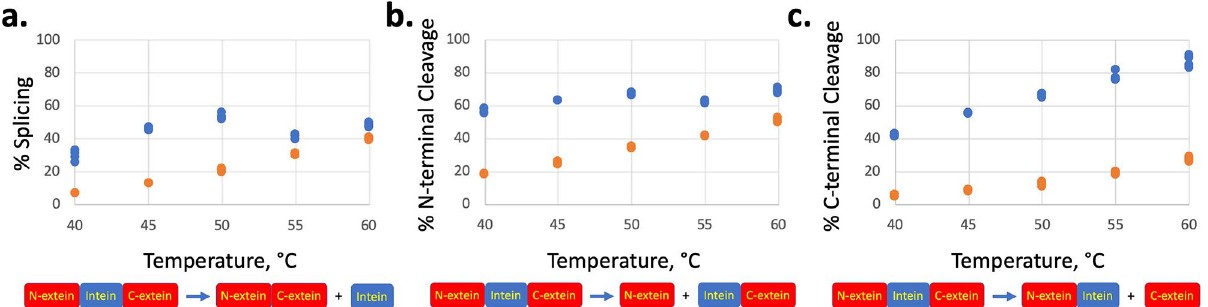
Figure 2. Protein splicing and splicing side reactions of the P. abyssi and P. horikoshii PolII inteins. Activity of the Pab PolII intein in blue and the Pho PolII intein in red. Each point represents analysis of a single experiment, and four experiments were used at each temperature point from one purified precursor protein. The extent of each reaction was measured by SDS-PAGE stained with Coomassie blue, with analysis of percentage of activity by densitometry using ImageJ. ( a ) Splicing as a function of temperature was measured by SDS-PAGE. Precursor intein fusion protein MIH-QN, which has a C-terminal Gln to Asn mutation to promote faster splicing, was incubated in buffer A supplemented with 2 mM TCEP and 5 mM EDTA for 8 h at the indicated temperatures. ( b ) N-terminal cleavage as a function of temperature measured by SDS-PAGE. Precursor intein fusion protein MIH-QACA, which has Cys + 1 to Ala and C-terminal Gln to Asn mutations to block the second and third steps of splicing, was incubated in buffer A supplemented with 100 mM DTT and 5 mM EDTA for 2 h at the indicated temperatures. ( c ) C-terminal cleavage as a function of temperature as measured by SDS-PAGE. Precursor intein fusion protein NIH-C1AQN, which has a Cys1 to Ala mutation to prevent the first step of splicing and a C-terminal Gln to Asn mutation to promote faster C-terminal cleavage, was incubated in buffer A supplemented with 2 mM TCEP and 5 mM EDTA for 5 h at the indicated temperatures. See Supplementary Figs. S1–S3 for SDS-PAGE